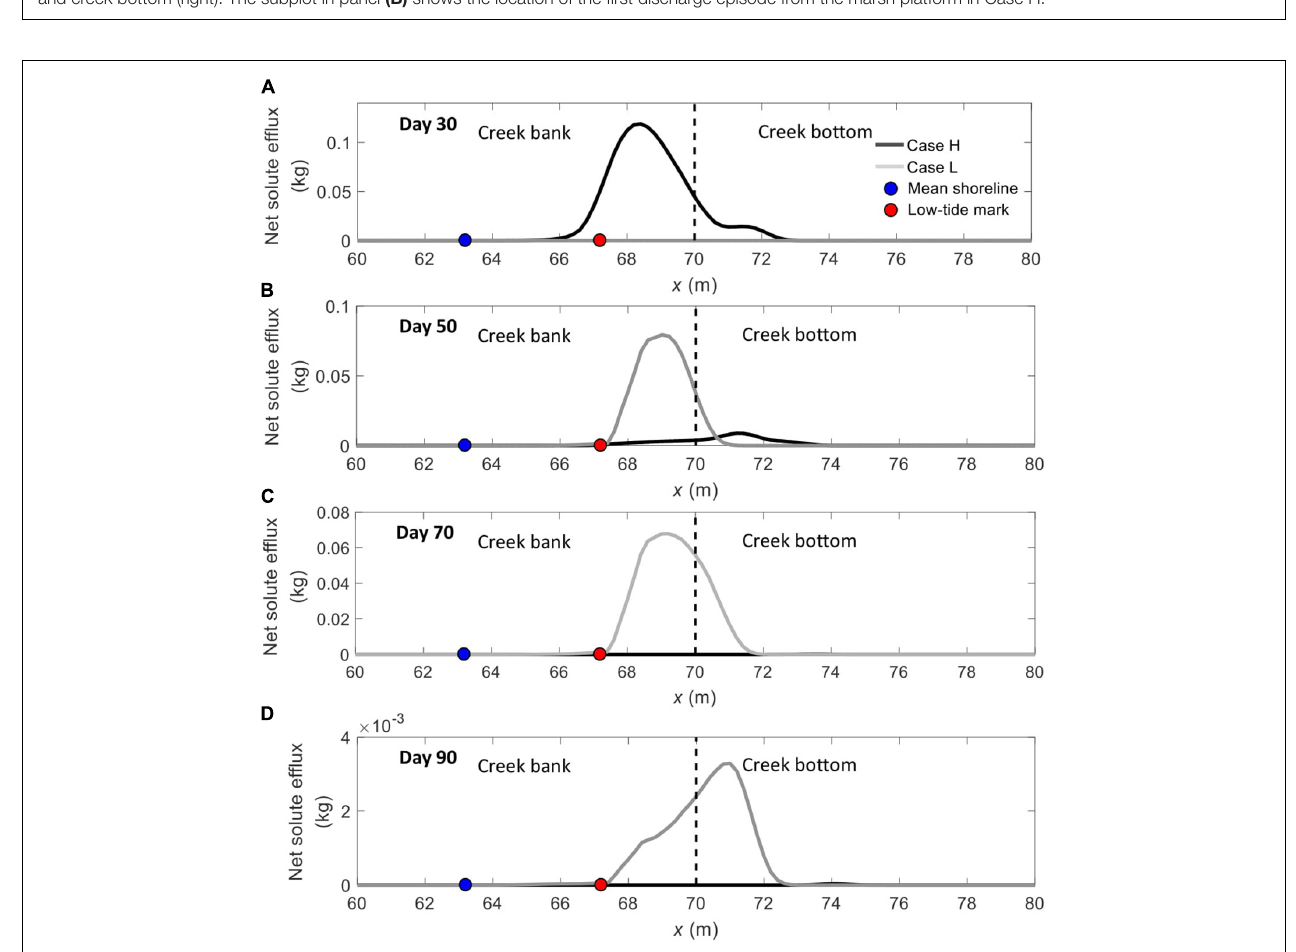
FIGURE 3 | Comparison of (A) time-dependent total solute efflux and (B) spatial distribution of net solute efflux across the SWI (BCDE in Figure 1 ) between Cases H and L. The blue and red nodes in panel (B) represent the mean shoreline and low-tide mark, respectively, while the vertical dashed line separates creek bank (left) and creek bottom (right). The subplot in panel (B) shows the location of the first discharge episode from the marsh platform in Case H.